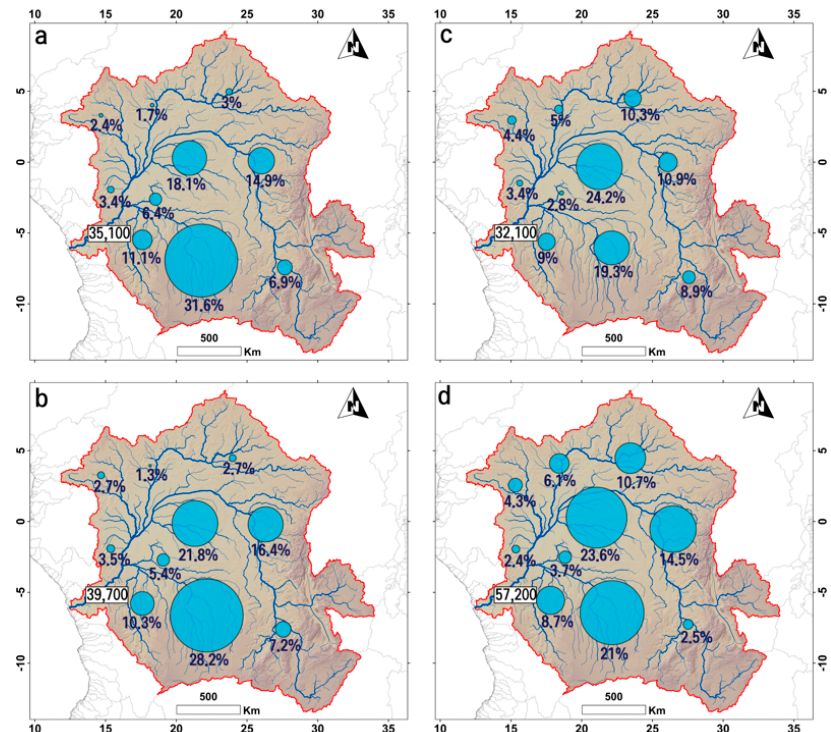
Figure 4. Participation of the different hydrological zones of the Congo Basin in the flow observed in Brazzaville/Kinshasa at different periods of the hydrological cycle (modified from Bricquet, 1995) [51] in March ( a ), May ( b ), August ( c ), and December ( d ). The area of the circles is proportional to the flow, and the percentage specifies the relative contribution of each zone to the flow in Brazzaville. For each zone, the flow retained takes into account its transfer time at the outlet. The units values are in m 3 s − 1 .